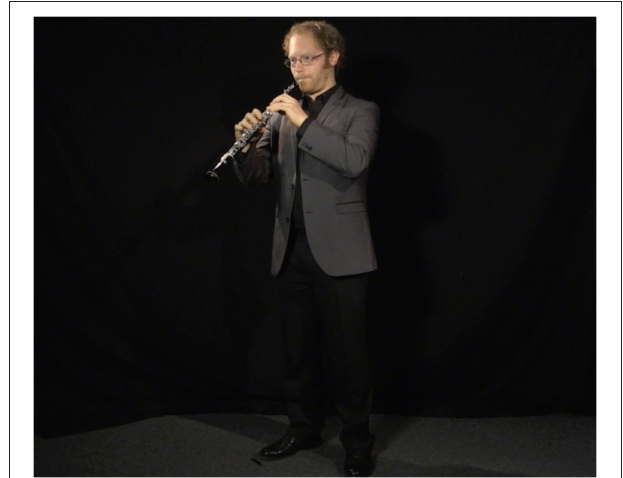
FIGURE 1 | Framing of the performer in the recorded video. The size of the performer in the scene was maximized to enhance the effect of the